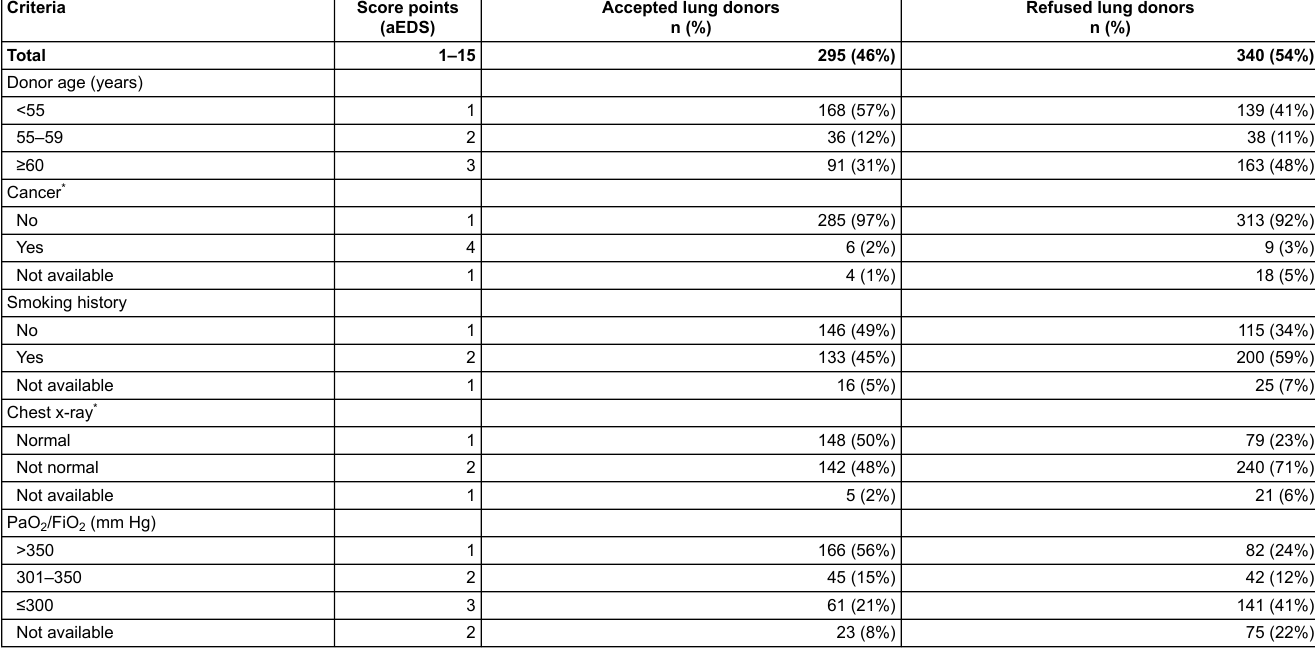
Table 2: Composition of the adapted Eurotransplant donor score (aEDS) for accepted vs refused lung donors. Criteria